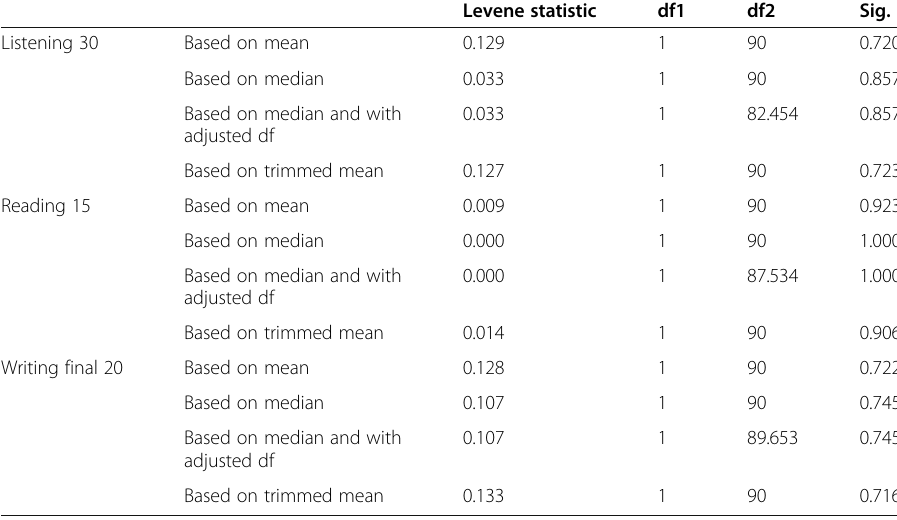
Table 9 Levene ’ s test of equality of error variances